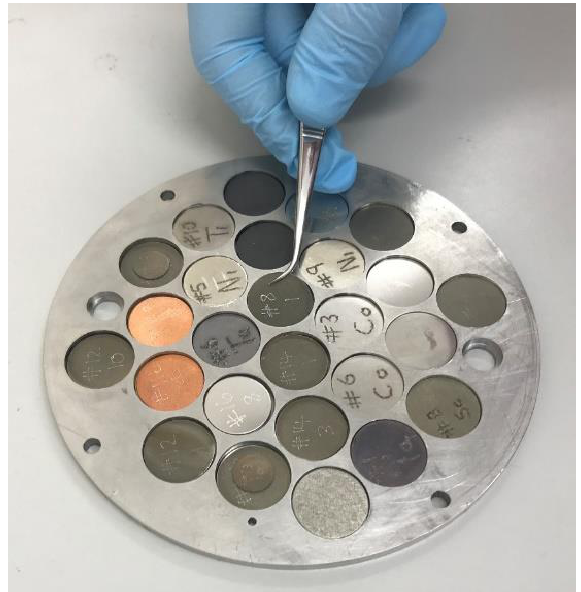
Fig. 2 Photograph of the outer long-term irradiation station sample holder loaded with ITER samples and dosimetry foils. The samples were irradiated in the C38 deuterium campaign at